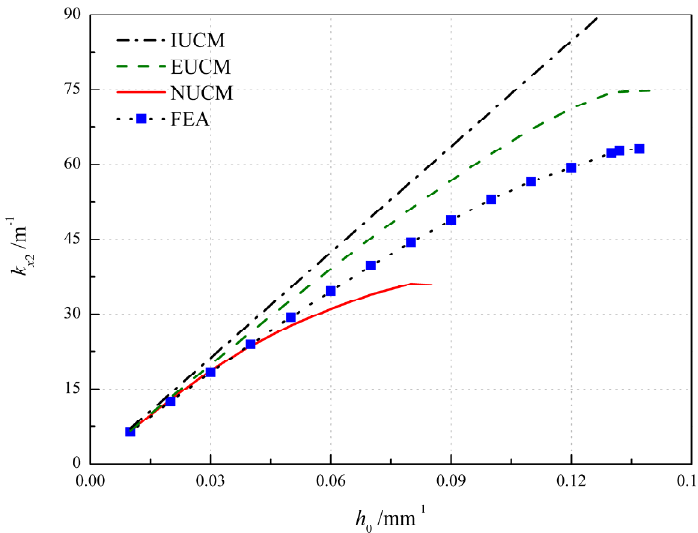
Figure 9. Variation of the principal curvature with respect to the initial natural curvature h 0 .